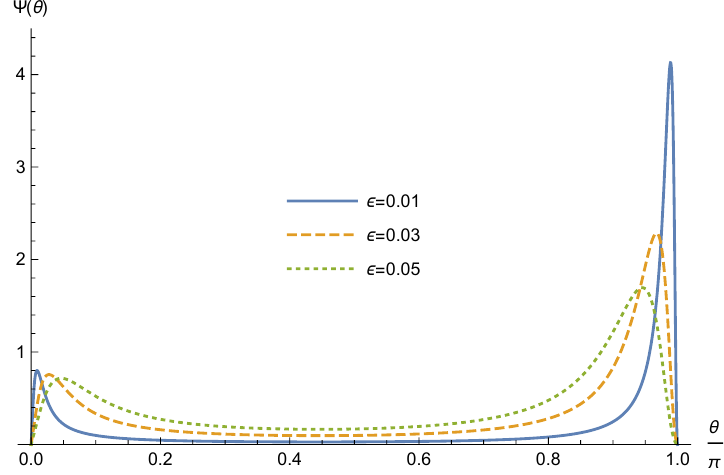
Figure 1 . An example of a localized mode (cid:9) = ^(cid:9)( (cid:18) ) e im N = S ’ 2 ker J + on the round sphere for m N = 1, m S = 2, (cid:17) N = 2 : 2, (cid:17) S = 3 : 7. The (cid:18) -dependent part ^(cid:9) of the separated wave function is plotted with the choice g (cid:15) = (cid:12) (cid:14) (cid:11) (cid:15) , where (cid:11) (cid:15) is the M(cid:127)obius transformation that maps the triple (cid:8) (cid:9) f 0 ; (cid:15); 1 g to 0 ; 1 ; 1 , and (cid:12) is a smooth function (cid:12) ( u ) = 2